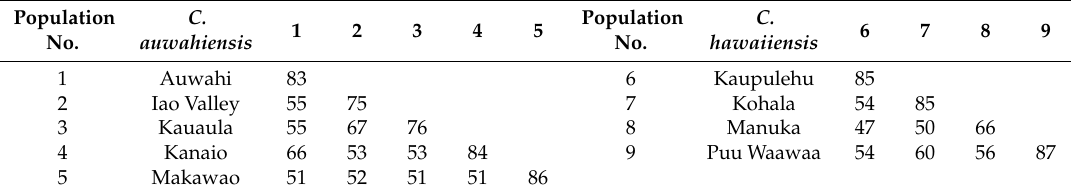
Table 4. Matrix of the average of coefficient genetic percent similarity (based on Gower similarity coefficients [20,21]) within and among populations of C. hawaiiensis and C. auwahiensis from combined RAPD and ISSR dataset analysis.